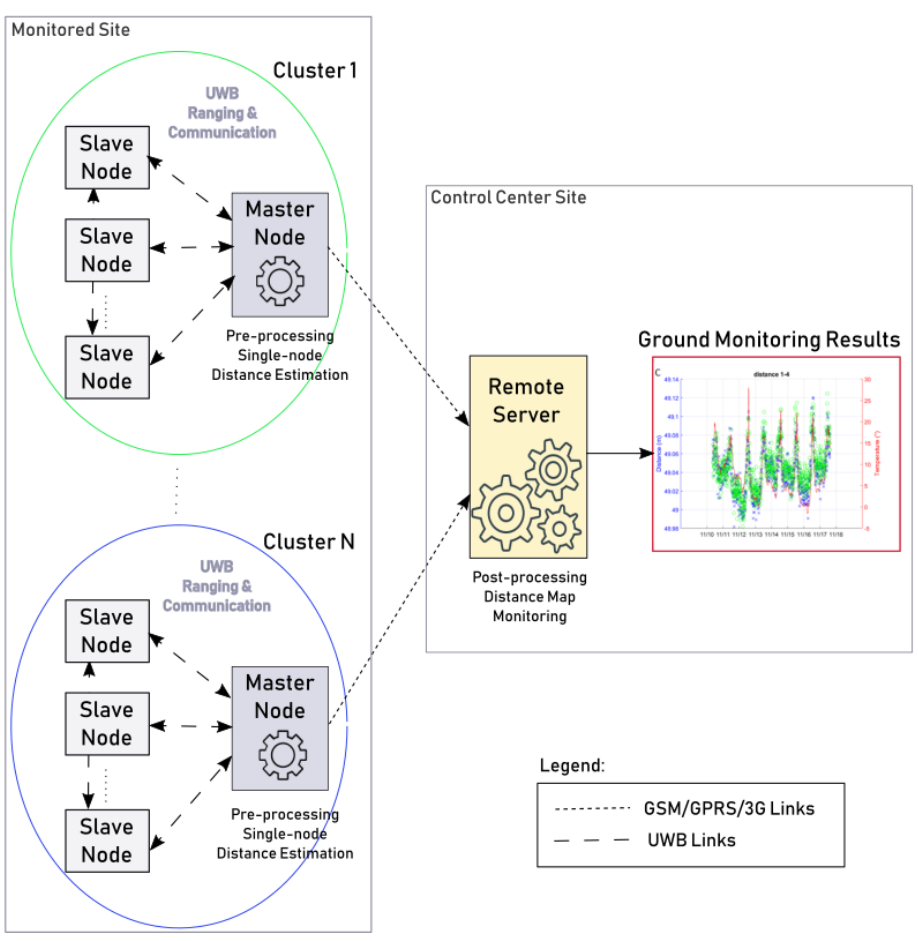
Figure 2. Wi-GIM system